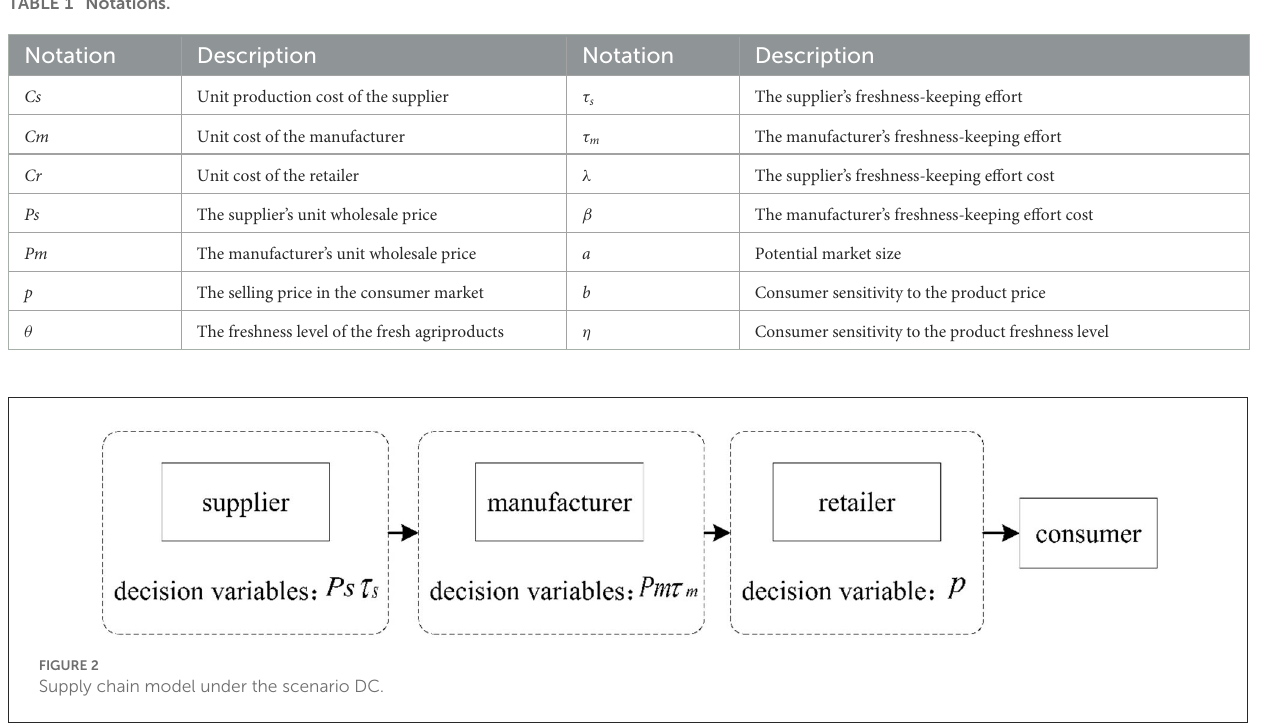
TABLE 1 Notations.